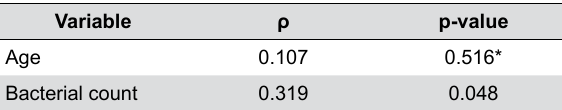
Table 3- Correlation between acetaldehyde concentration (in mouth air) and other parameters